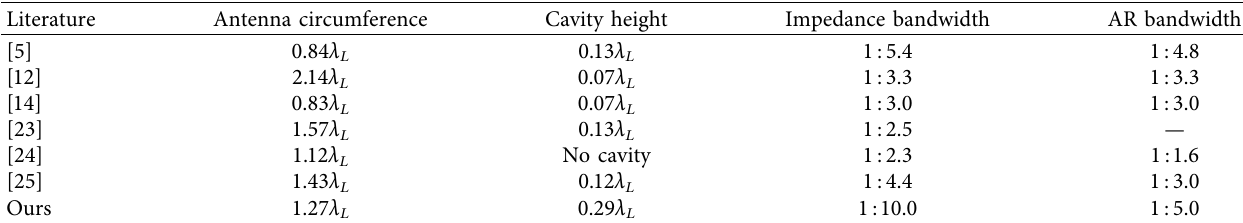
Table 1: Comparisons between spiral antennas in different